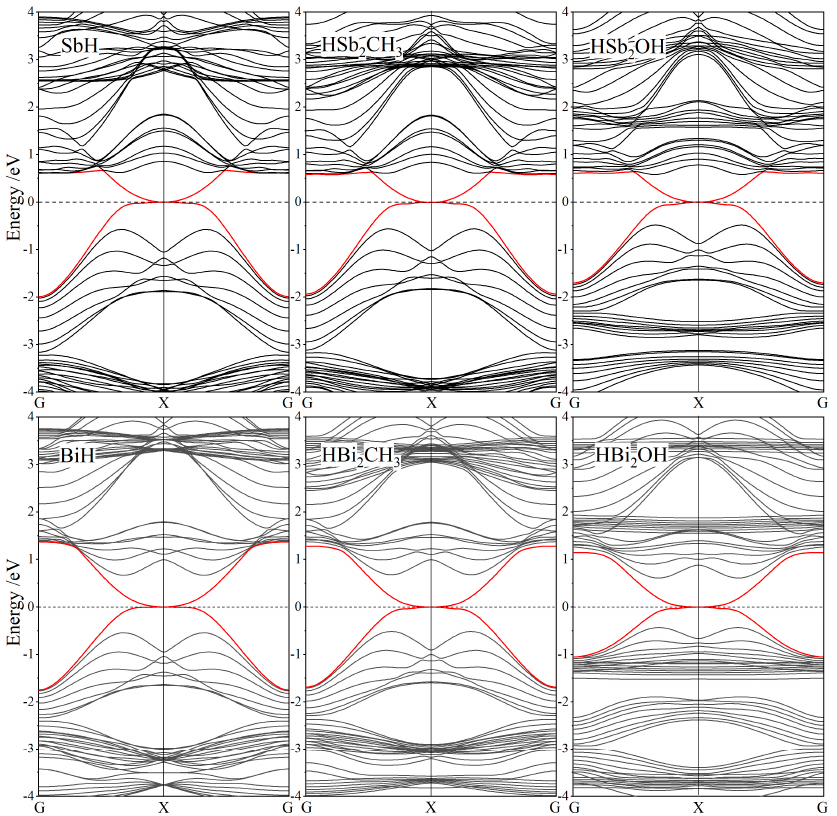
Figure 5. SOC-included band structures of zigzag nanoribbons of Janus Sb and Bi monolayers (functionalized asymmetrically by H atom and CH 3 or OH), and SbH and BiH nanoribbons are presented for comparison, with red color indicating edge states and Fermi level being referenced as energy zero.